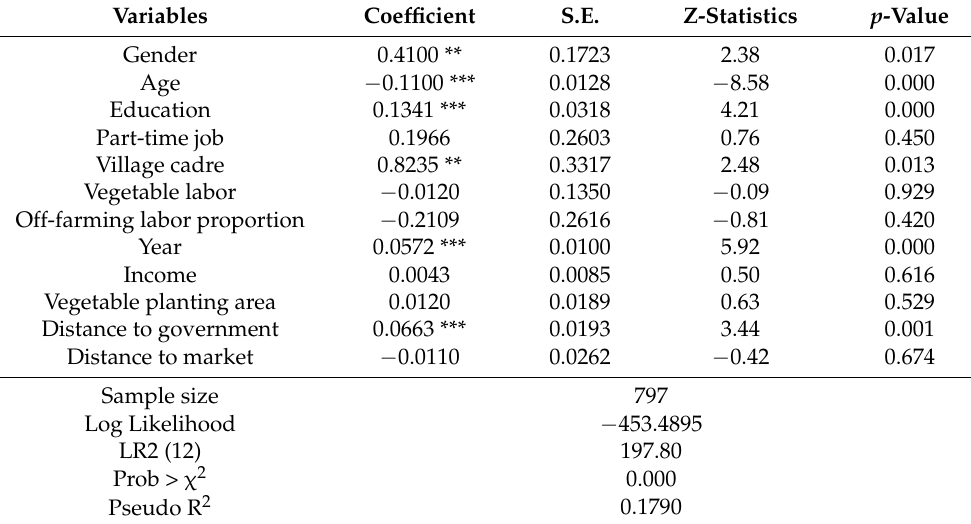
Table 2. Logit model estimation results of farmers’ decisions regarding Internet use.